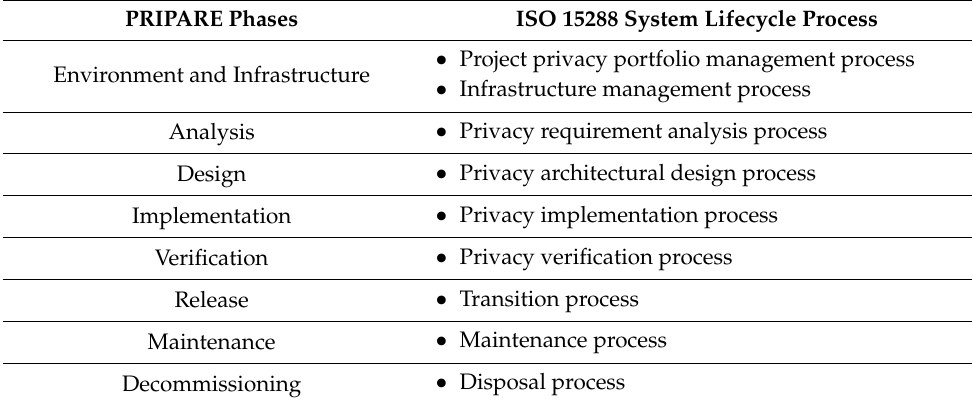
Table 2. International Organization for Standardization (ISO) 15288 for mapping PReparing Industry to Privacy-by-design by supporting its Application in Research (PRIPARE) phases